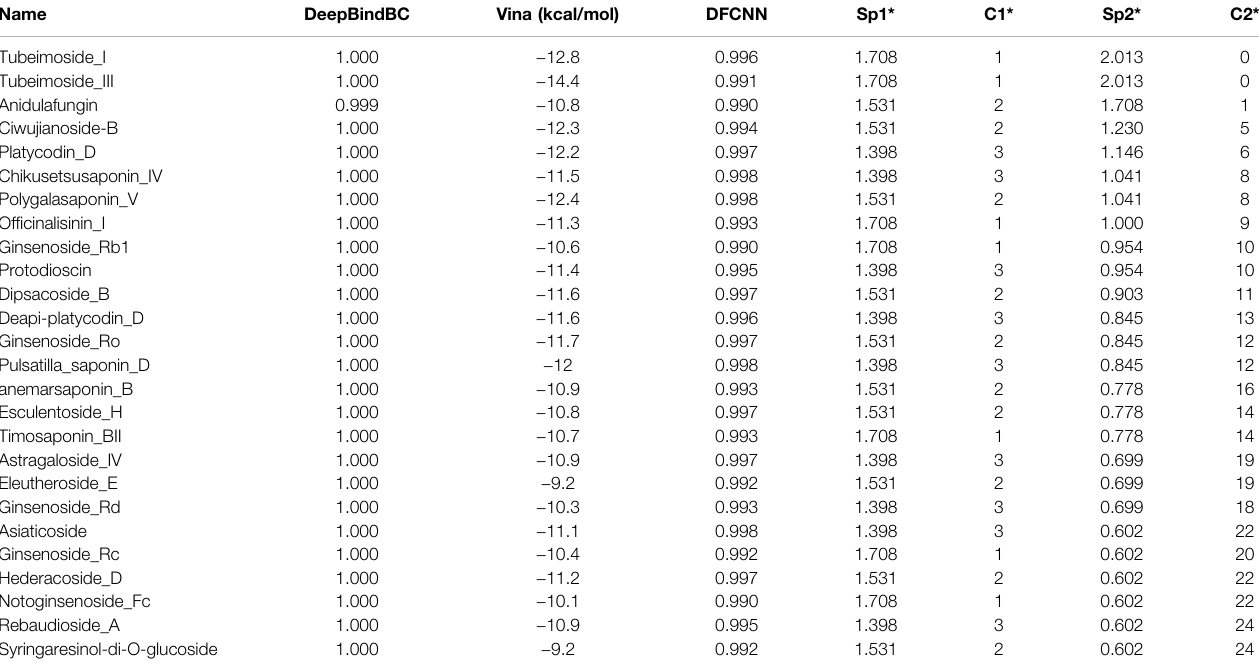
TABLE 1 | The result list with corresponding prediction scores after gradually screening by DFCNN, Autodock Vina, DeepBindBC, DFCNN speci fi city checking, and Autodock Vina relative speci fi city checking.